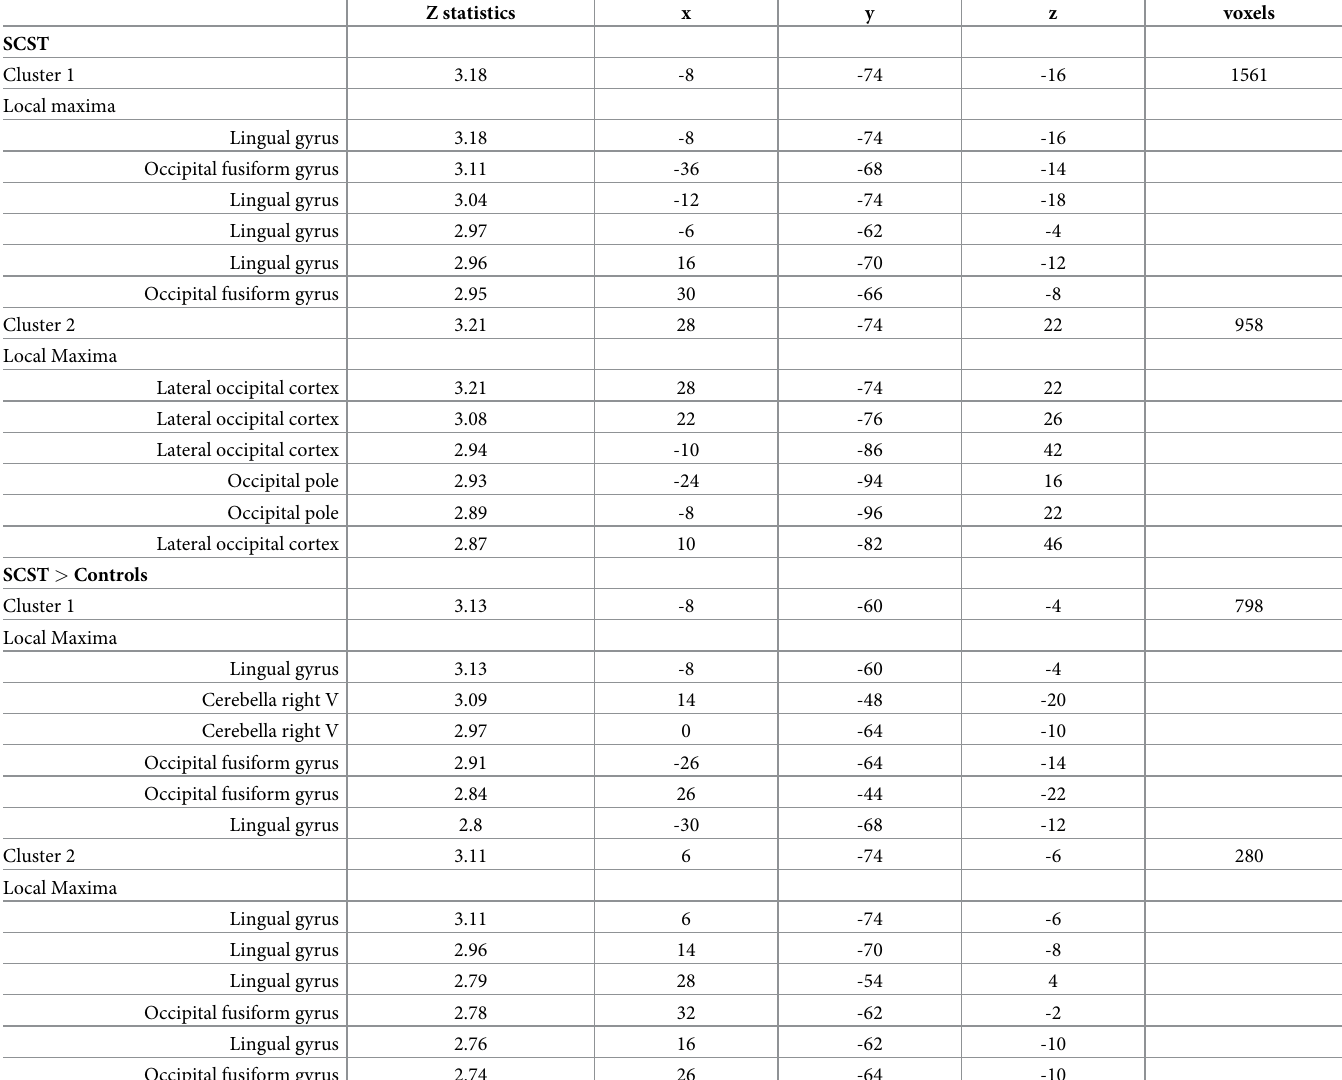
Table 3. Clusters that showed significantly increased PPI connectivity for the contrast of [emotion matching > gender matching] during the Facial Affect Matching task at 12 wks compared to